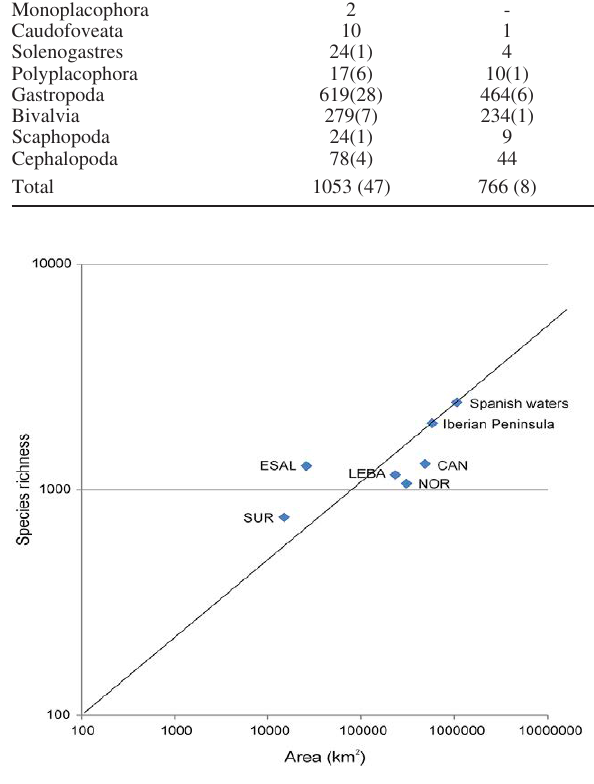
Fig. 2. – Species-area plot for the five demarcations, the total of the four Iberian demarcations, and the total of Spanish waters.